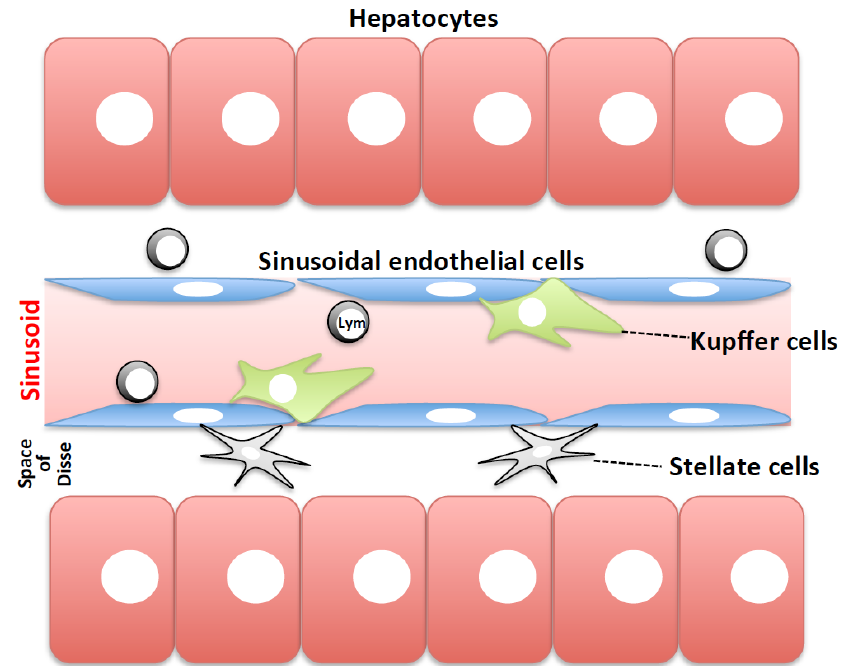
Figure 1. Schematic structure of the liver. Hepatic sinusoids are composed of sinusoidal endothelial and Kupffer cells. Blood circulates within the sinusoids in the liver. Hepatocytes, or liver parenchymal cells are localized to the space of Disse, distant from the sinusoid. Natural killer (NK) and invariant NK T (NKT) cells are abundant in the liver. Lym: lymphocytes, including NK cells, NKT cells, and other